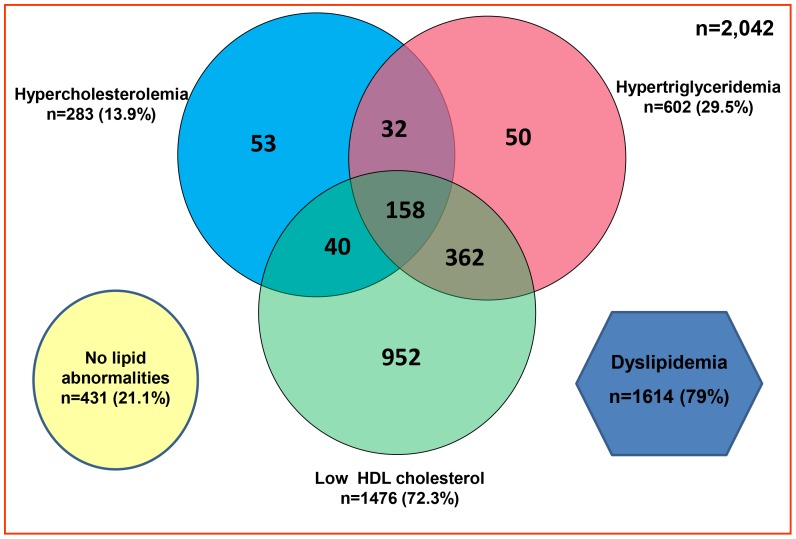
Venn diagram to show the overlap of the individual components of dyslipidemia [Hypercholesterolemia, hypertriglyceridemia and low HDL-cholesterol].